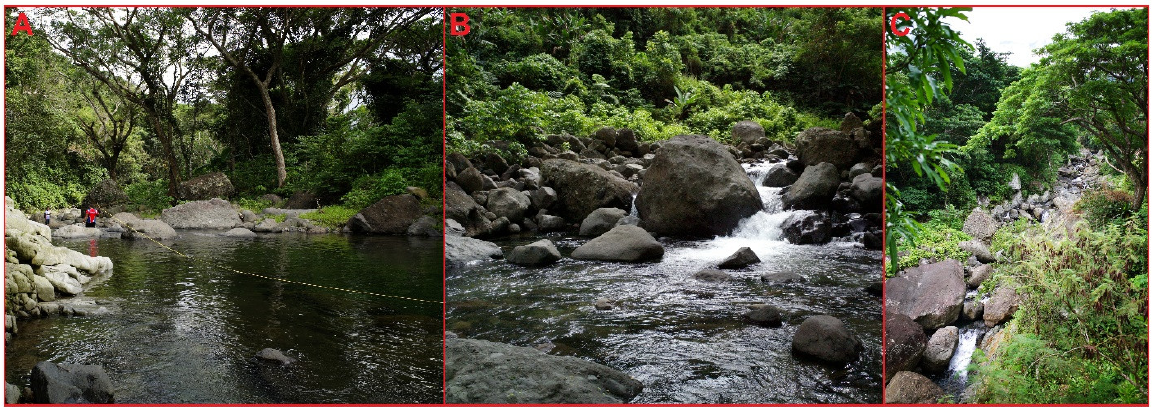
Figure 7. The Sabeto River of western Viti Levu, Fiji: ( A ) a low gradient, plane-bed reach 0.1 km upstream of Station 1, ( B ) the change from steep, headwater, step-pool conditions to gentle, downstream plane-bed conditions 0.2 km upstream of Station 1 and ( C ) the steep, cascade conditions characteristic of the river’s headwaters.